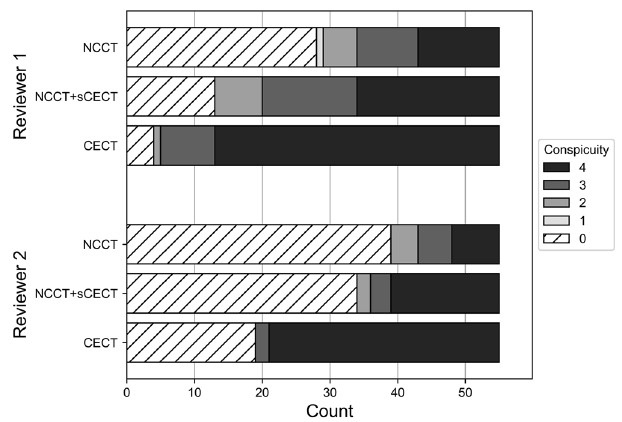
Figure 6. Comparison of radiologists’ ratings regarding lesion conspicuity of mediastinal lymph nodes in test set 2 between non-contrast CT (NCCT), non-contrast CT with synthetic contrast-enhanced CT (NCCT + sCECT), and contrast-enhanced CT (CECT). Undetected lesions are labeled as 0 and indicated by hatched